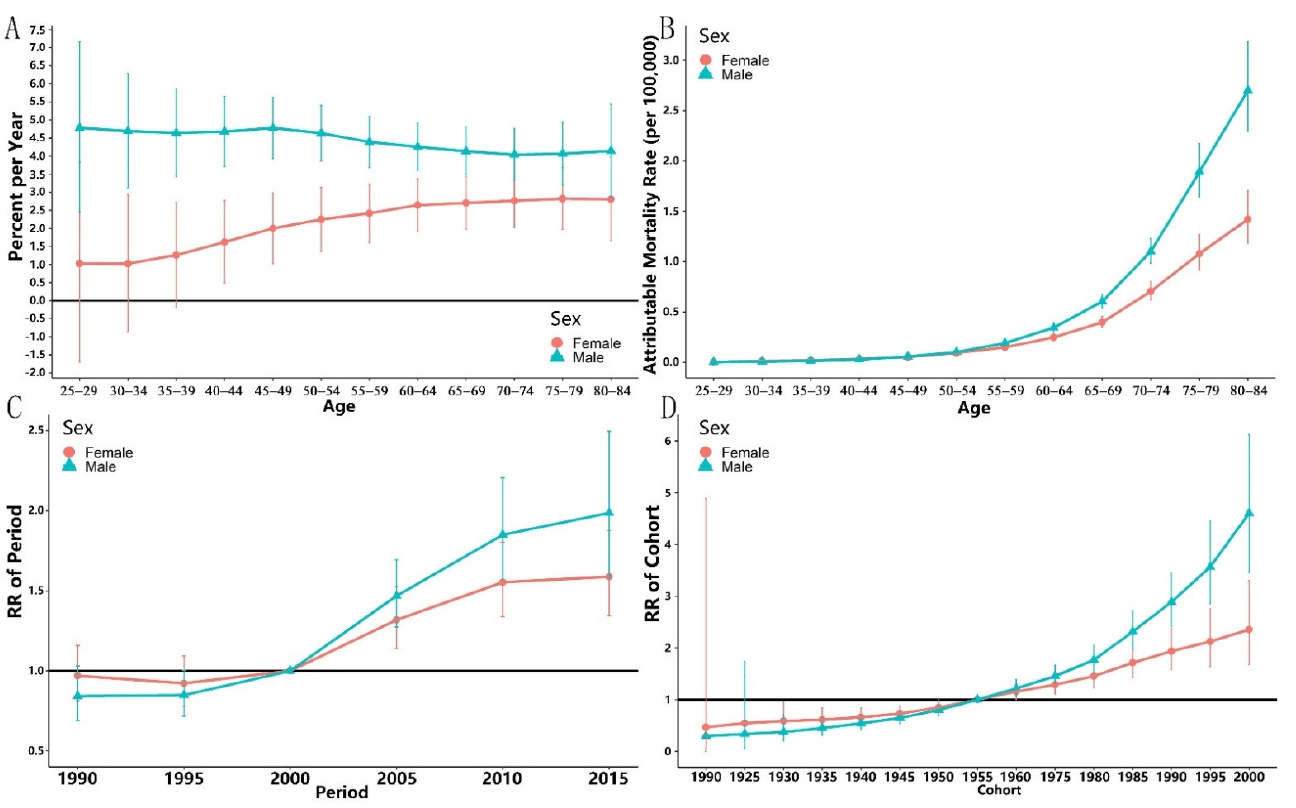
Figure 2. Local drifts, longitudinal age curves, estimated relative risk (RR) for period and cohort, and corresponding 95%CI for both sexes in China. ( A ) Local drifts for both sexes; ( B ) longitudinal age curve; ( C ) period RR; ( D ) cohort RR.